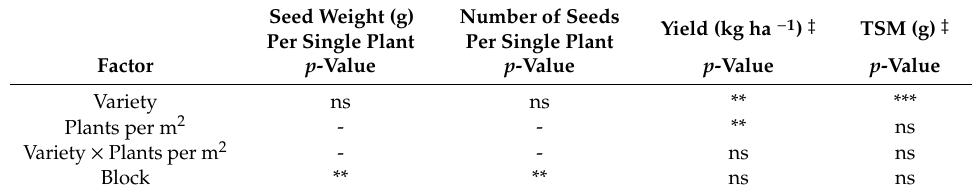
Table 5. Results of the statistical evaluation of seed weight (g) per single plant, number of